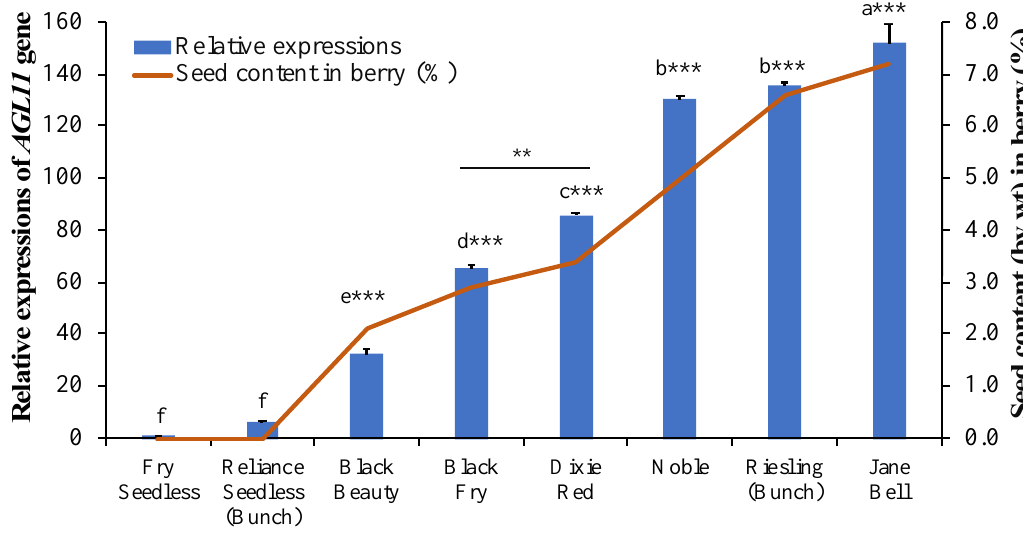
Figure 4. The relative expressions of grape AGL11 gene in pea-size berries and percentage of seed content (by weight) in berry of selected seeded and seedless muscadine and bunch grape cultivars. The vertical bars represent the standard error of three biological replicates. Bars with different letters differ significantly according to Tukey’s post-hoc test (*** p < 0.001, ** p < 0.01).